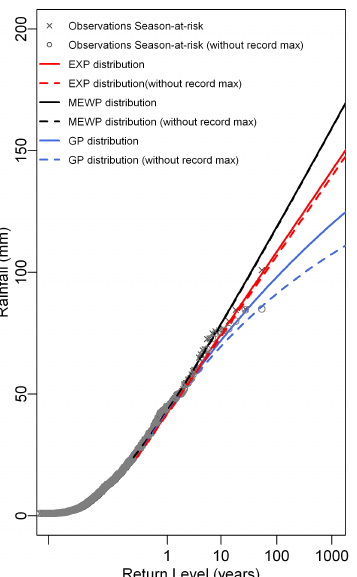
Fig. 10. Sensitivity of the extreme daily rainfall quantiles to the maximum value recorded by the Lyon rain gauge during the “season-at-risk” (June to November) for each model (EXP, MEWP and GP